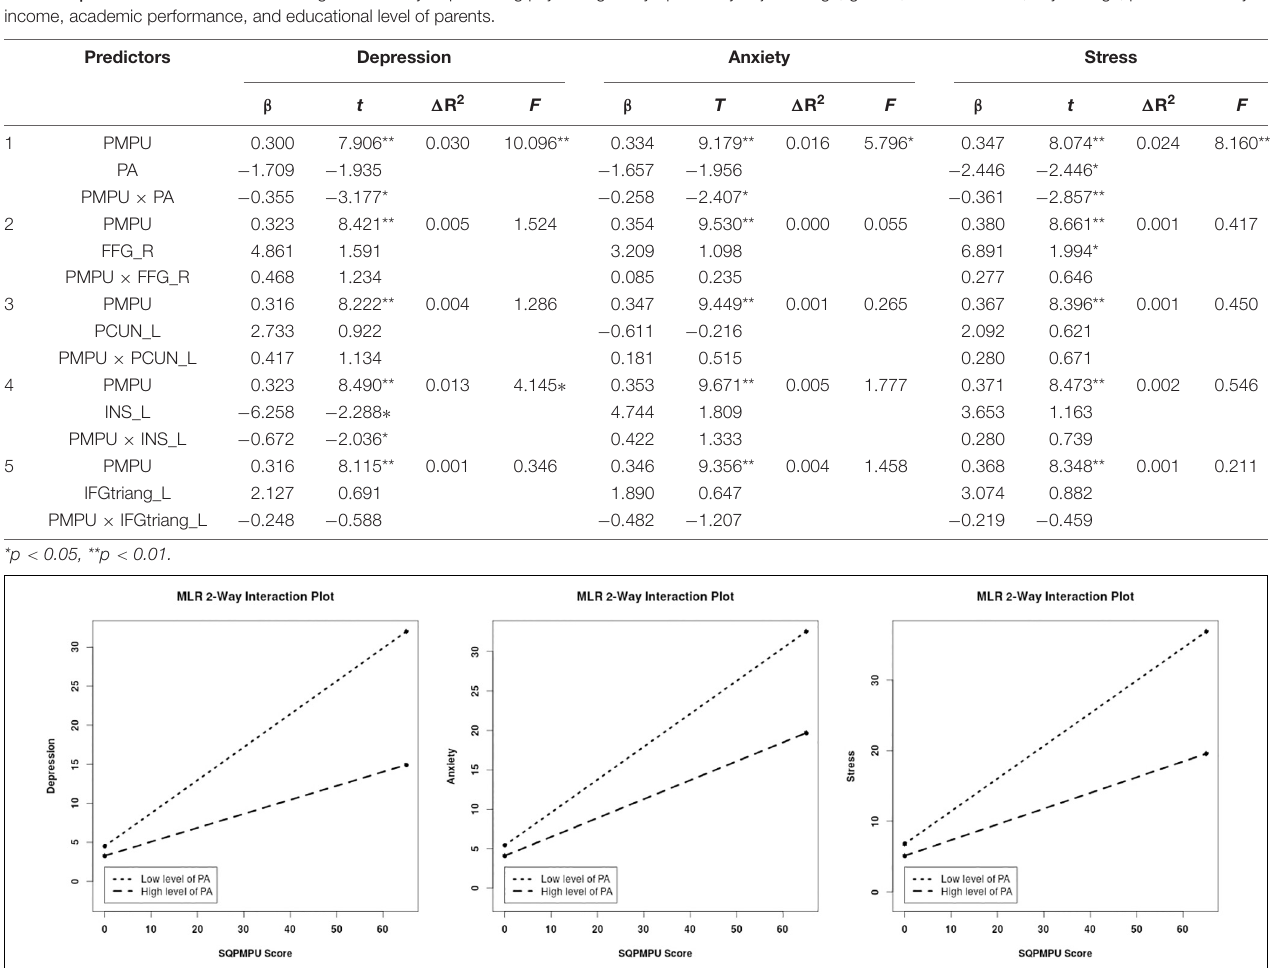
FIGURE 3 | PA moderated the association between problematic mobile phone use (PMPU) and psychological symptoms. Simple slopes are plotted at low (M − 1 SD) and high (M + 1 SD)